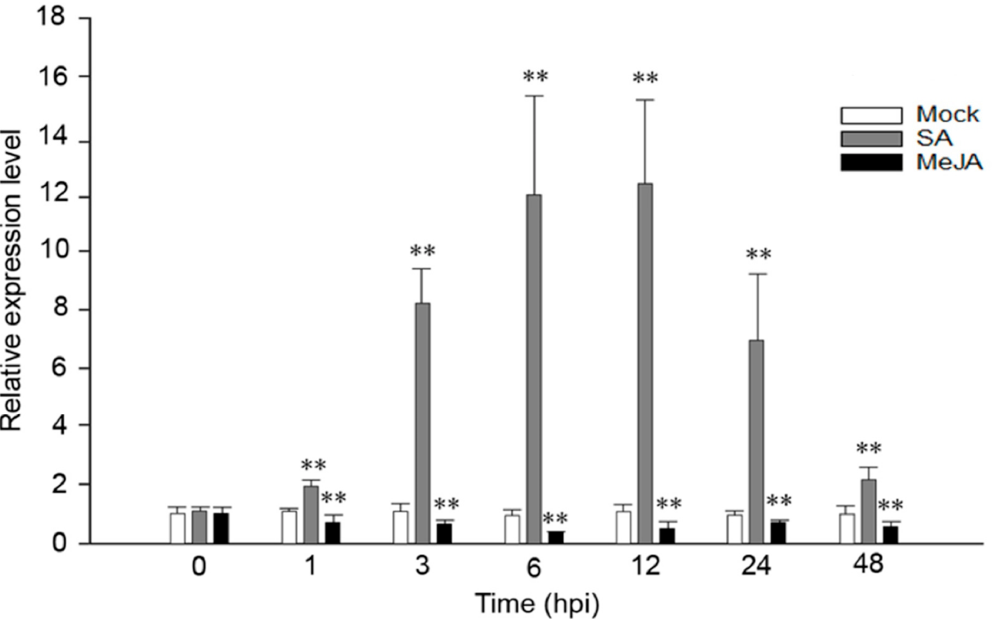
Figure 1. Expression levels of VaRGA1 in V. amurensis “Shuanghong” following salicylic acid (SA) and methyl jasmonate (MeJA) treatments. The expression level of VaRGA1 in “Shuanghong” under non-stressed conditions was defined as 1.0. Data represent mean values ± SD from three independent experiments. Asterisks show statistically significant di ff erence (** p < 0.01, Student’s t